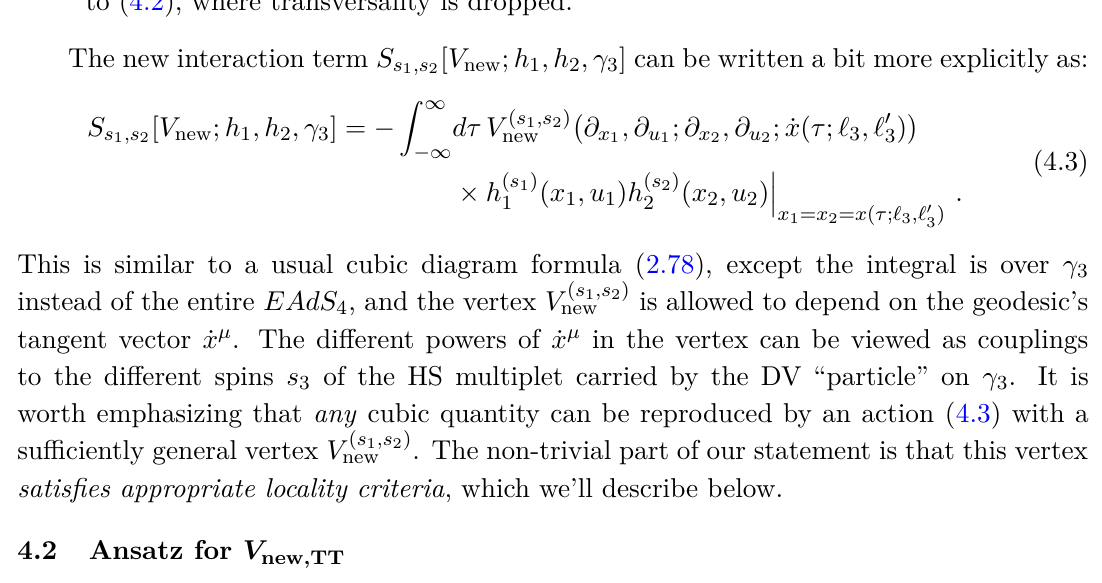
is a new vertex that couples new are confined to new